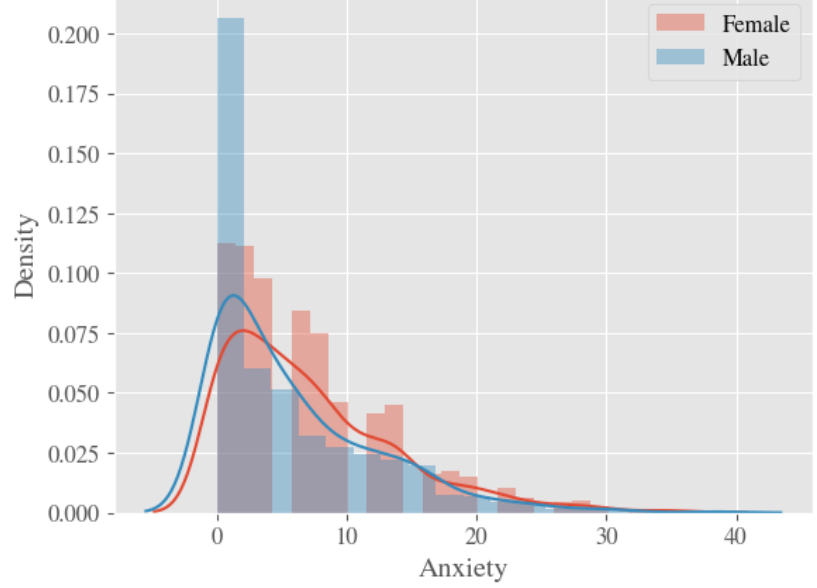
Figure 3. The Distribution of Levels of Anxiety in Men and Women.